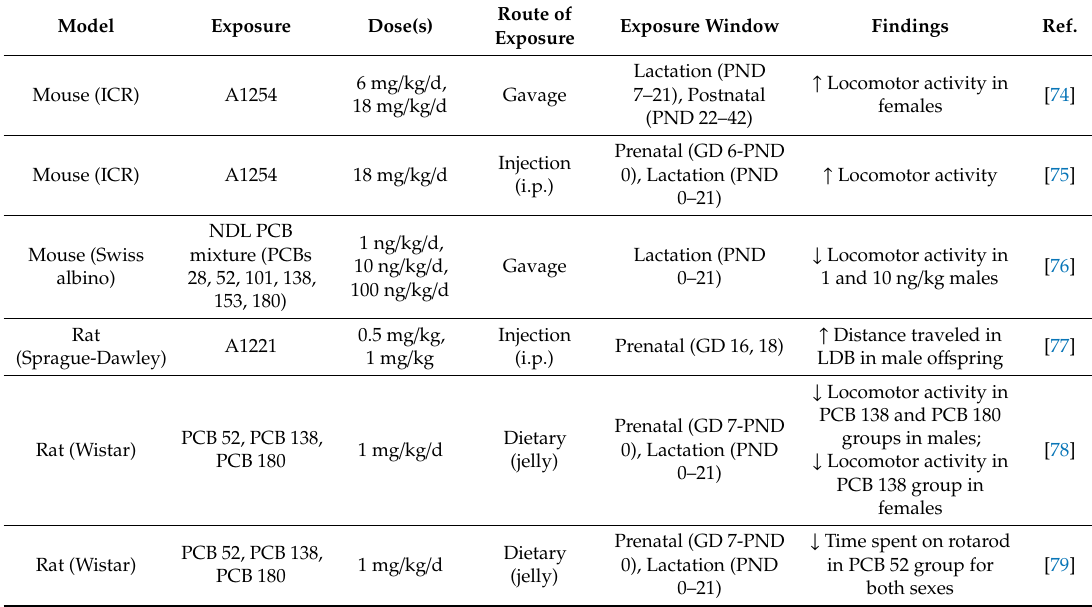
Table 1. E ff ects of developmental PCB exposure on locomotor